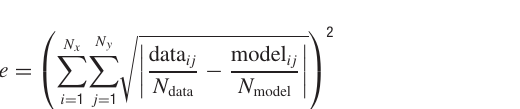
Equation (1) can be replaced